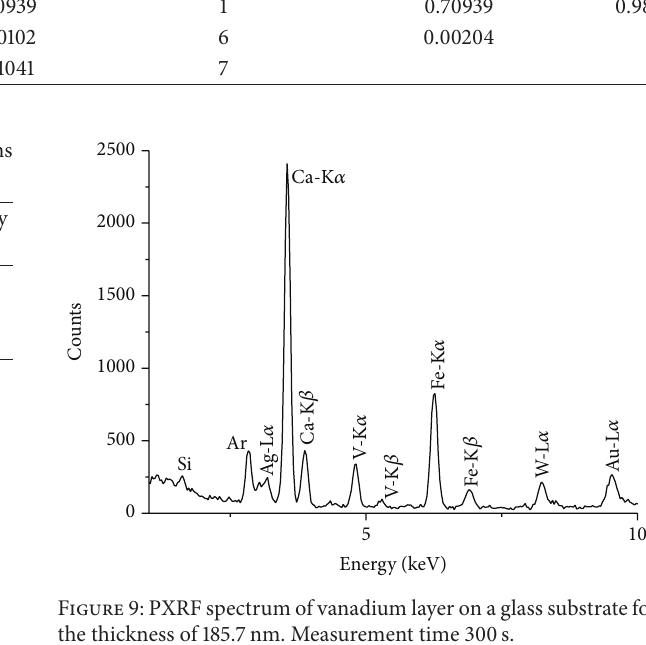
𝑌 = 10611.42 − 13.34𝑋